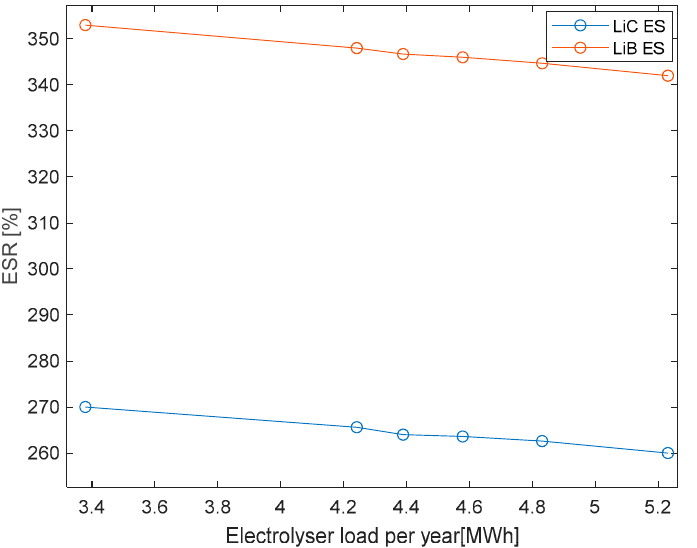
Figure 14. IR of the LiC and LiB ES after 10 years of operation as a function of the energy delivered to the electrolyser load.